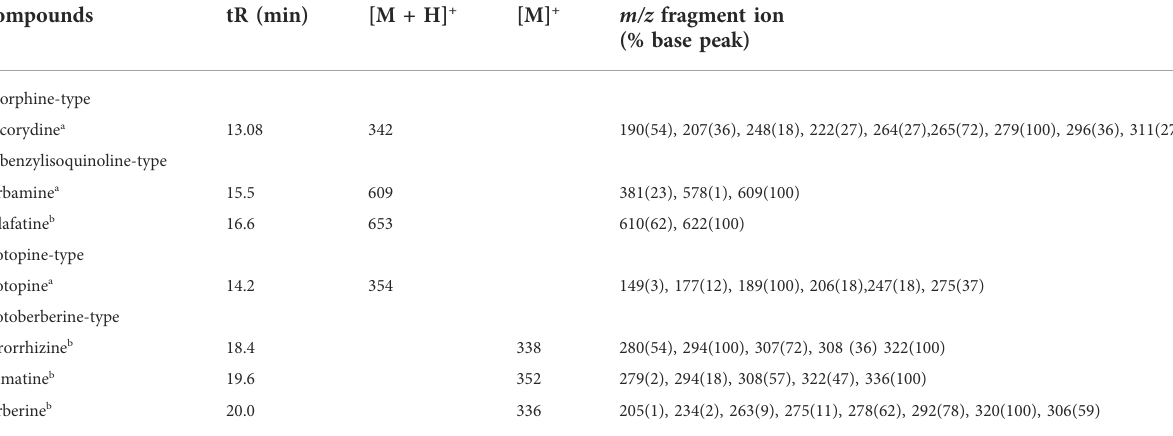
TABLE 1 Mass Spectral data and retention times (tR) of alkaloids identi fi ed from roots of B. microphylla by HPLC ESI-MS/MS.